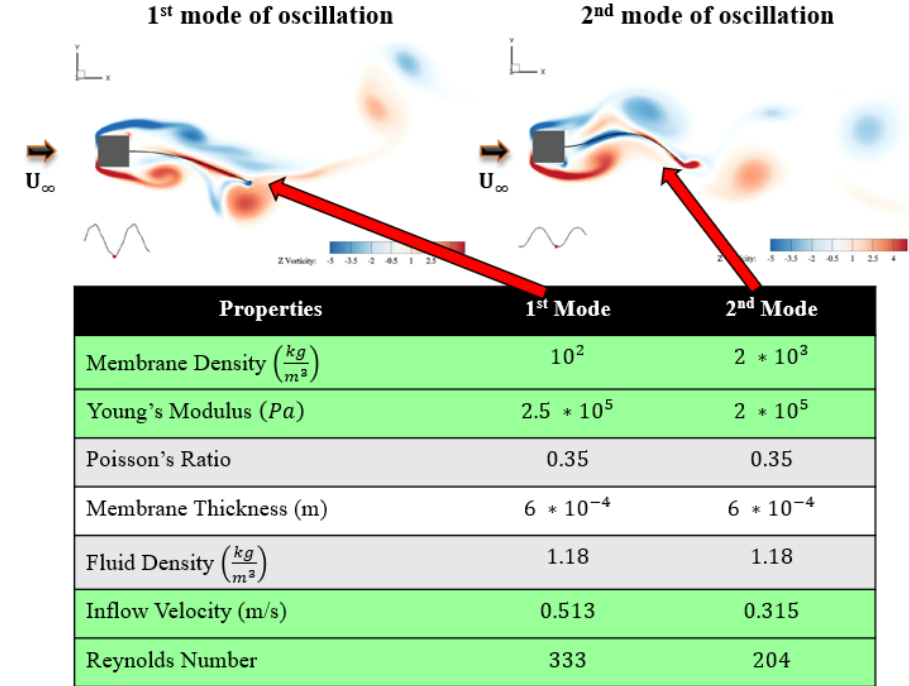
Figure 4. Comparison of the 1st and 2nd oscillation modes of the membrane in the wake of a square cylinder. Multiple parameters are responsible for changes in different modes of oscillations but the dominant being the material density